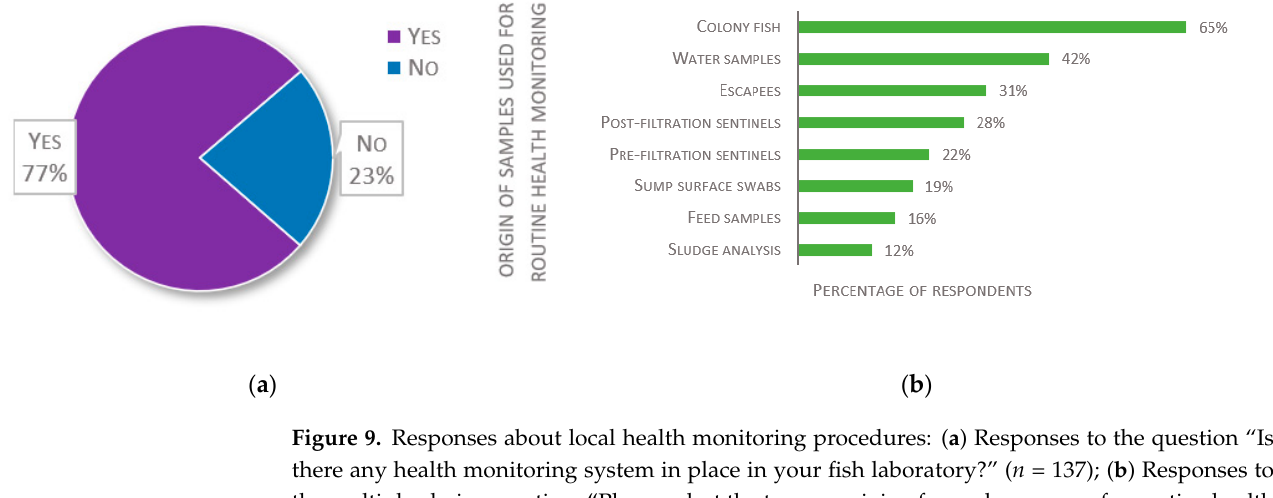
Figure 9. Responses about local health monitoring procedures: ( a ) Responses to the question “Is there any health monitoring system in place in your fish laboratory?” ( n = 137); ( b ) Responses to the multiple-choice question: “Please select the type or origin of samples you use for routine health monitoring”, presented as percentage of respondents ( n = 106). Each respondent was allowed to select multiple answers.